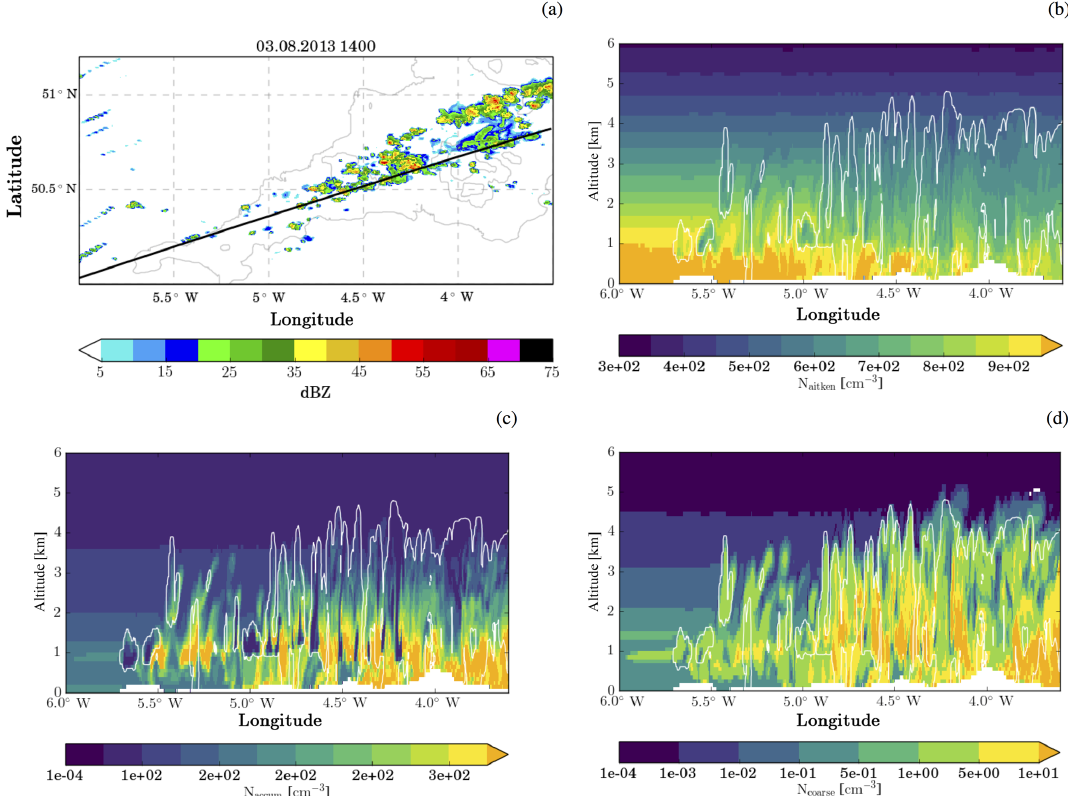
Figure 4. Aerosol fields from the simulation with aerosol processing at 14:00UTC. (a) The colour shading shows the column maximum re- flectivity and the black line indicates the location of the cross sections plotted in the other panels: (b) number density of Aitken-mode aerosol, (c) accumulation-mode aerosol, and (d) coarse-mode aerosol. The white contour lines in panels (b, c, d) indicate areas with hydrometeor mixing ratios larger than 1 mg kg − 1